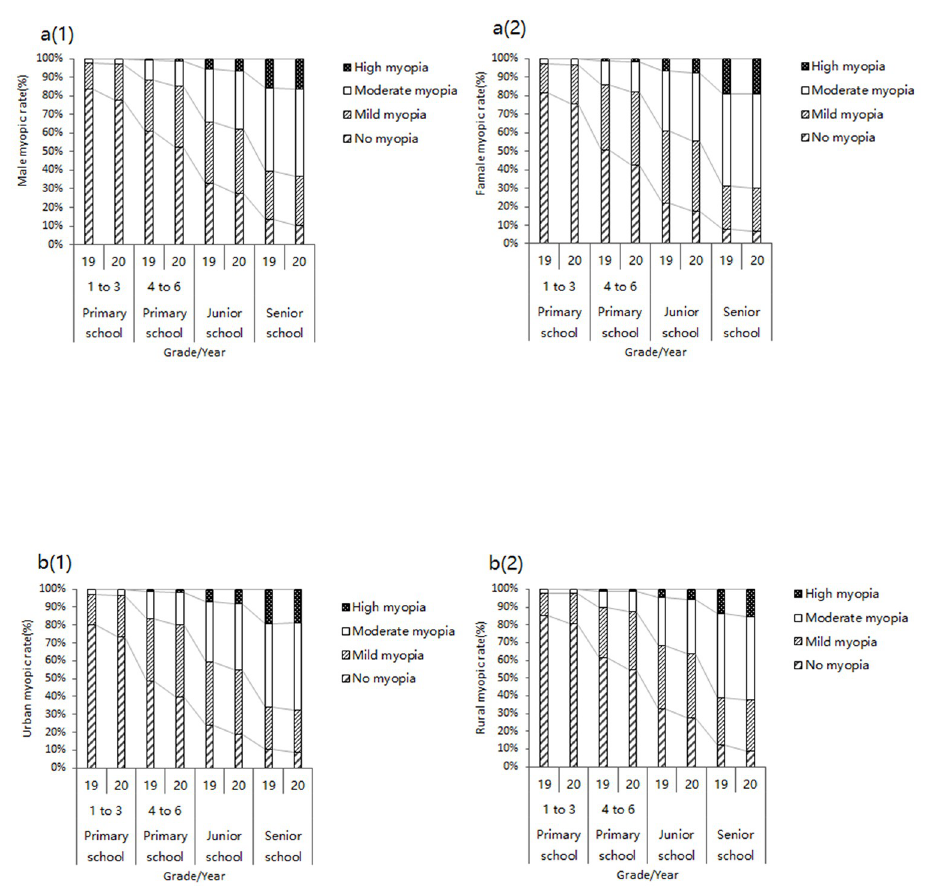
Fig 1. The distribution of different category of myopic prevalence in gender and